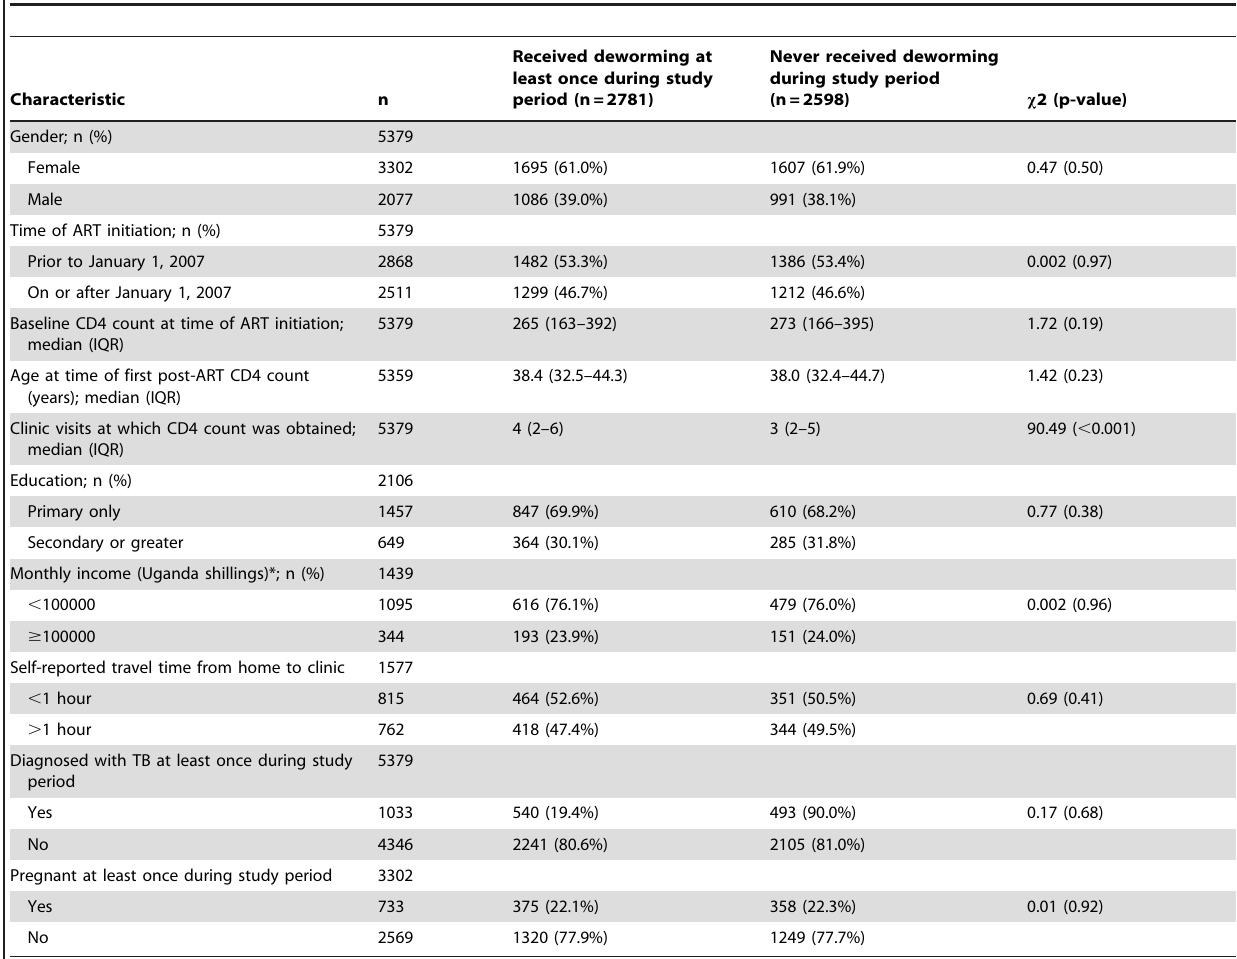
Table 1. Subject characteristics.